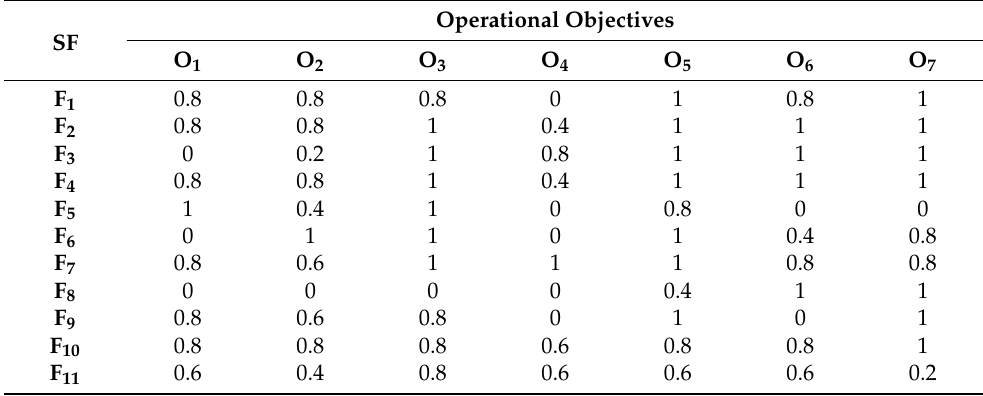
Table 6. Fuzzy relation matrix—SFs to OOs—Numerical membership values